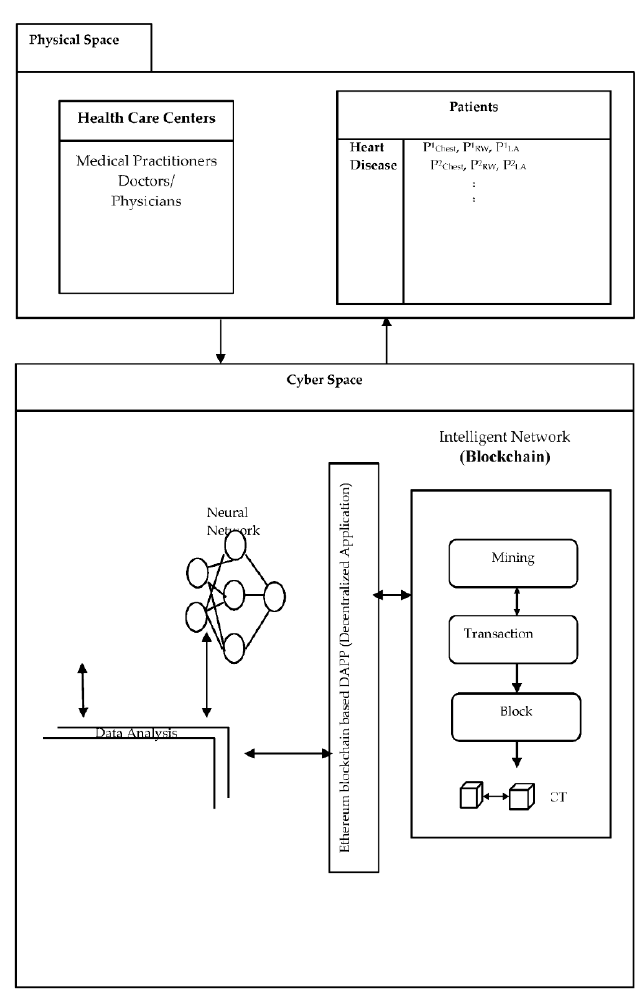
Figure 1. Proposed Architecture.